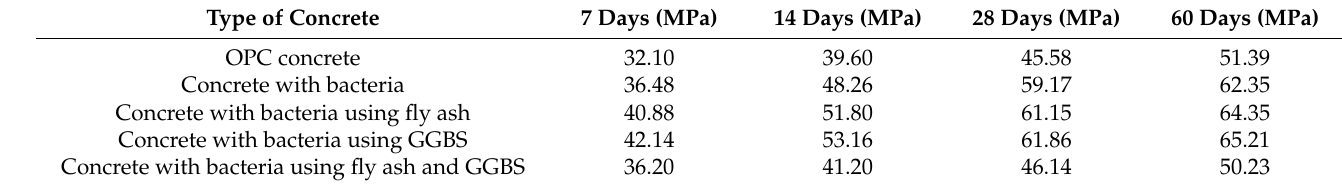
Table 9. Compressive strength values for concretes with different compositions (adapted from